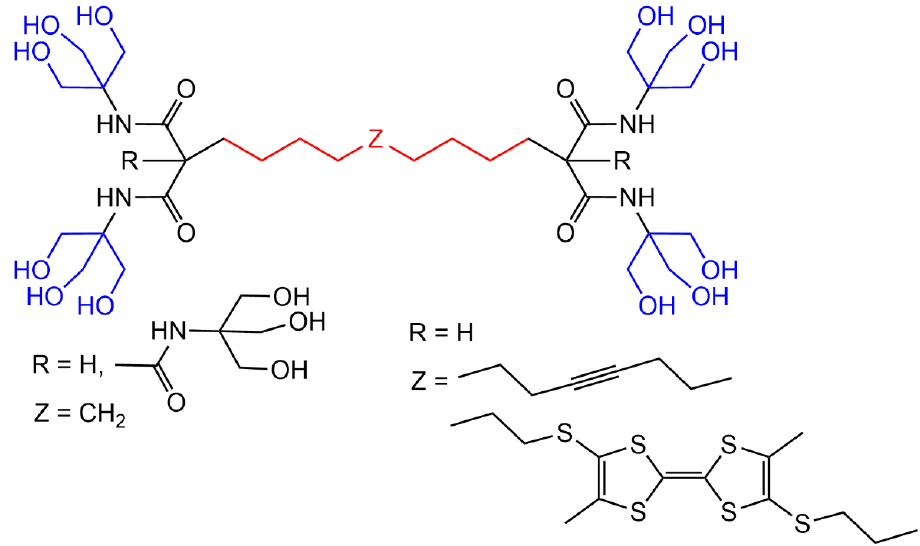
Figure 1. Structure of bolaform arborols suitable for forming hydrogels.